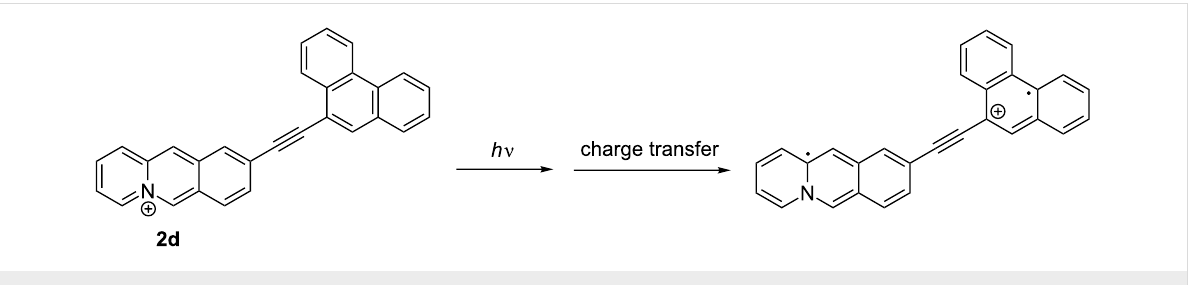
Scheme 3: Photoinduced charge transfer upon the excitation of derivative 2d